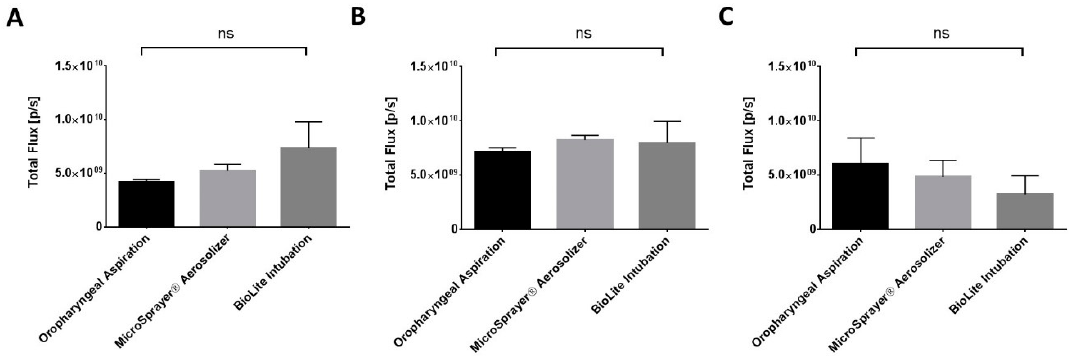
Figure 6. Total fluorescence flux ( ρ /s) (oral cavity, trachea, and the lungs) in mice at ( A ) 1 h, ( B ) 4 h, and ( C ) 24 h after pulmonary administration of near-infrared fluorescent Degradex ® poly( D , L -lactide-co-glycolide) (PLGA) microspheres using oropharyngeal aspiration, the MicroSprayer ® Aerosolizer, and the BioLite Intubation System ( n = 3–4, mean ± SEM, one-way ANOVA, Tukey’s multiple comparison test).